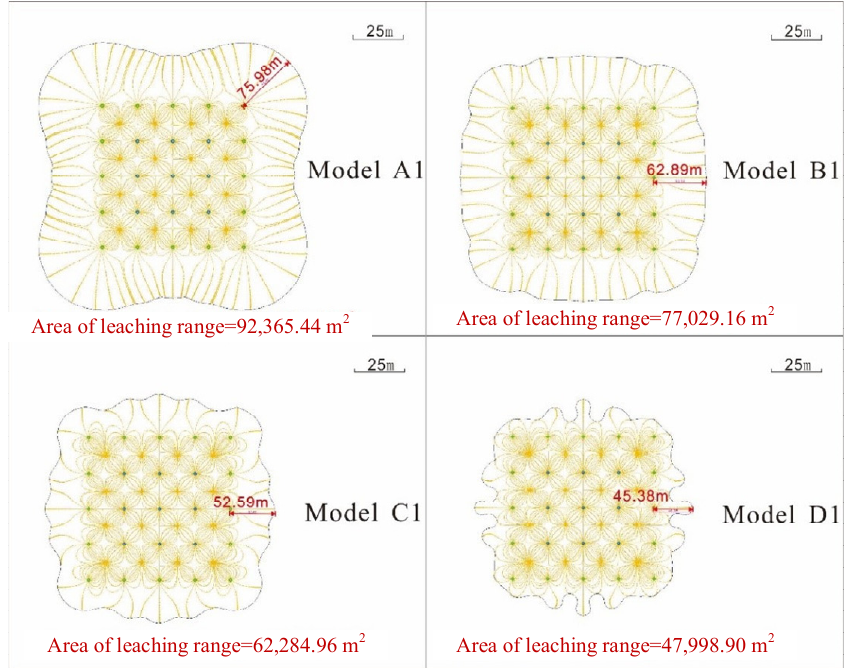
Figure 6. Comparison chart of leaching range under the condition of equilibrium pumping injection ratio (TEF = TIF).